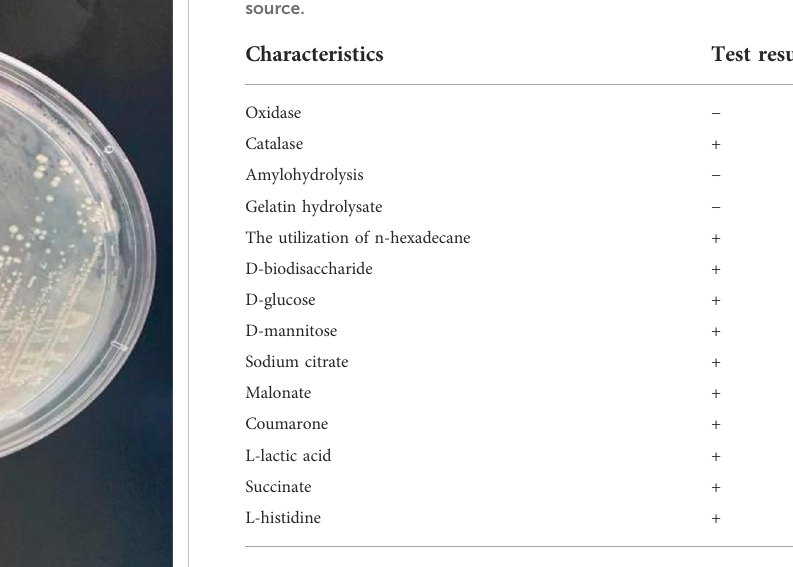
TABLE 1 The microbiological characteristics of strain AO-06 capable of growing in the presence of 3MI as the only available carbon